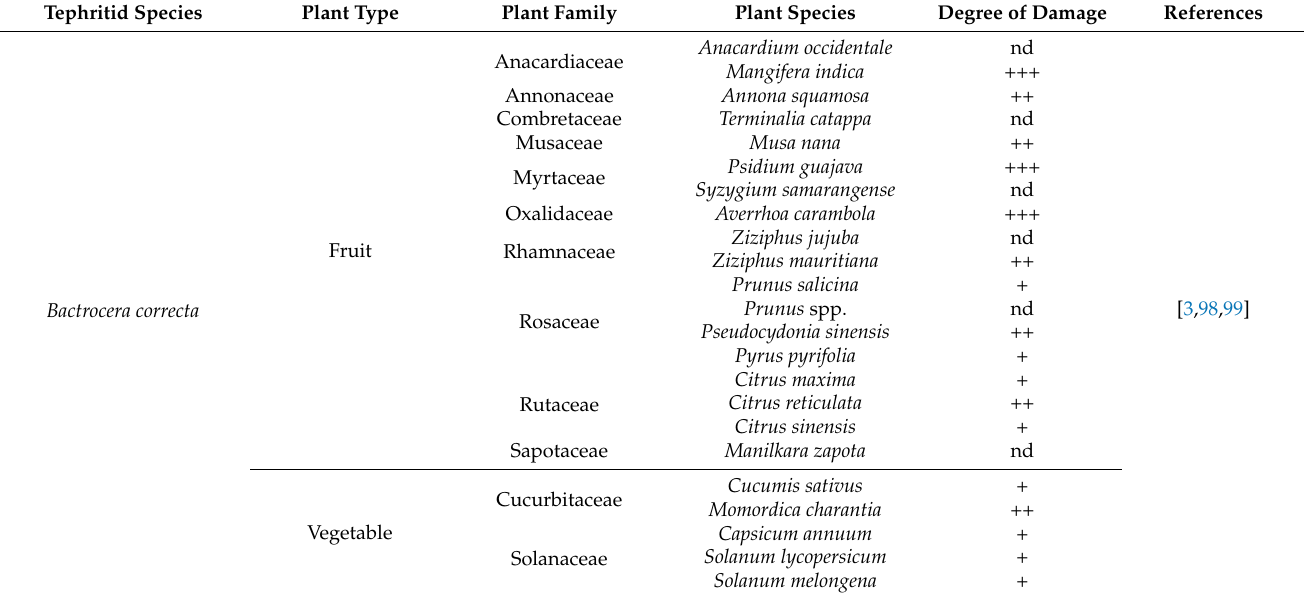
Table 2. Records of host plants of tephritid fruit flies in China. Tephritid